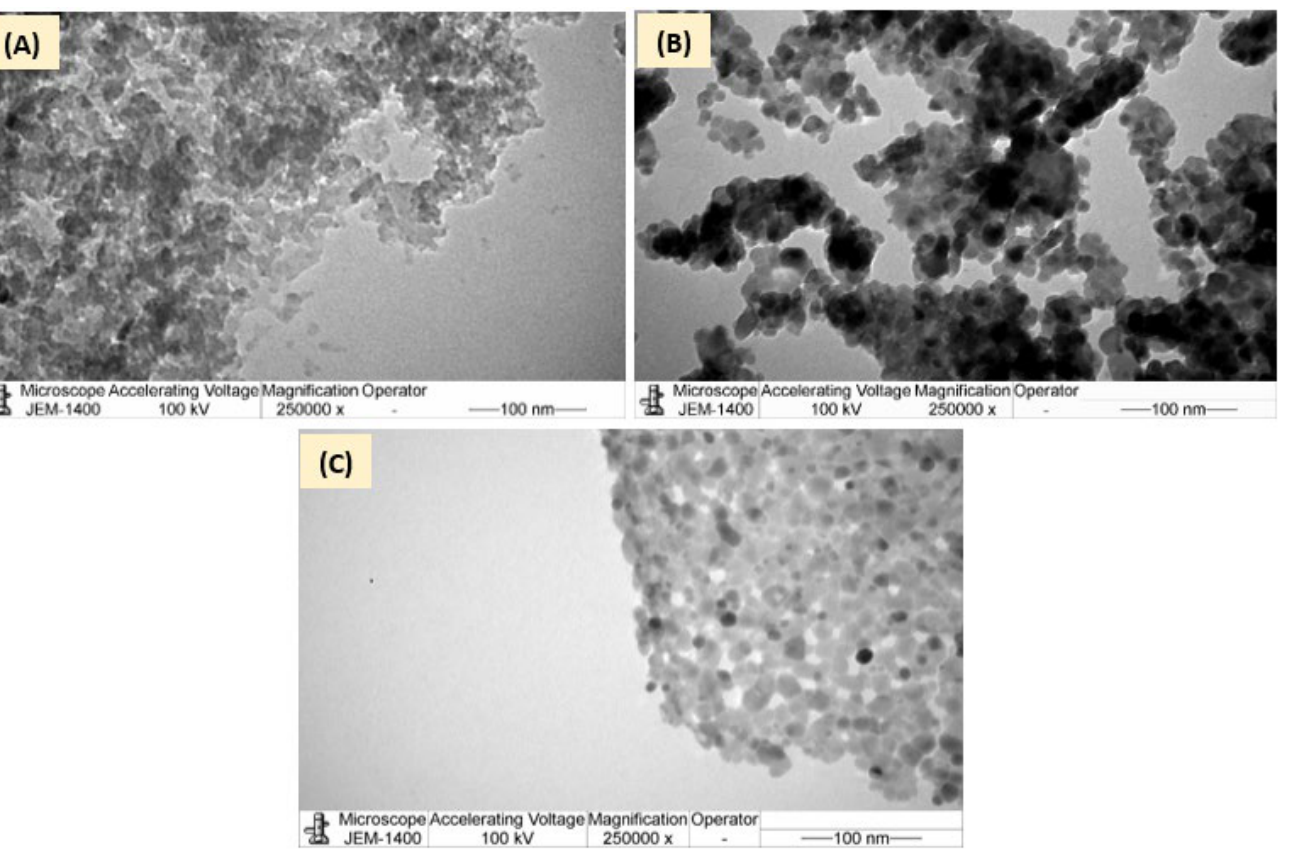
Figure 6. Transmission electron microscope (TEM) of ( A ) AC, ( B ) ZnFe 2 O 4 , and ( C ) ZFAC.